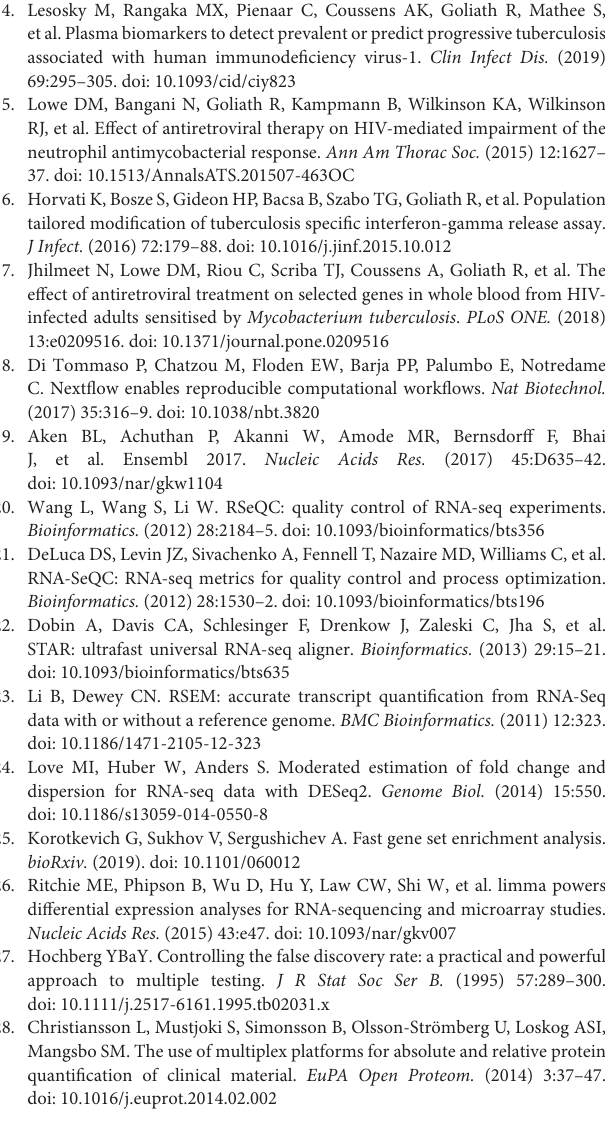
Supplementary Figure 3 | Change in CD4T cells expressing the chemokine receptors CXCR3, CCR4, and CCR6, determined by flow cytometry analysis in peripheral blood mononuclear cells in a subset of 25 patients from the same cohort, at day 0 and 6 months of ART. Supplementary Table 1 | Analytes evaluated in the study. Supplementary Table 2 | Differentially expressed genes revealed by RNA sequencing. This list is provided in an Excel spreadsheet. Supplementary Table 3 | MSD analysis results.